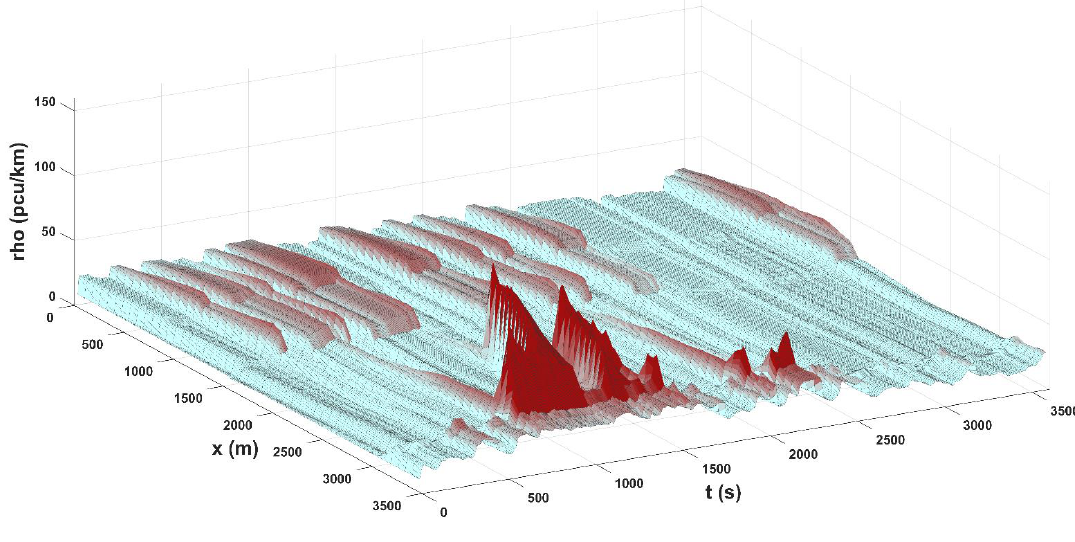
Figure 4. Density in time and space in scenario 2.